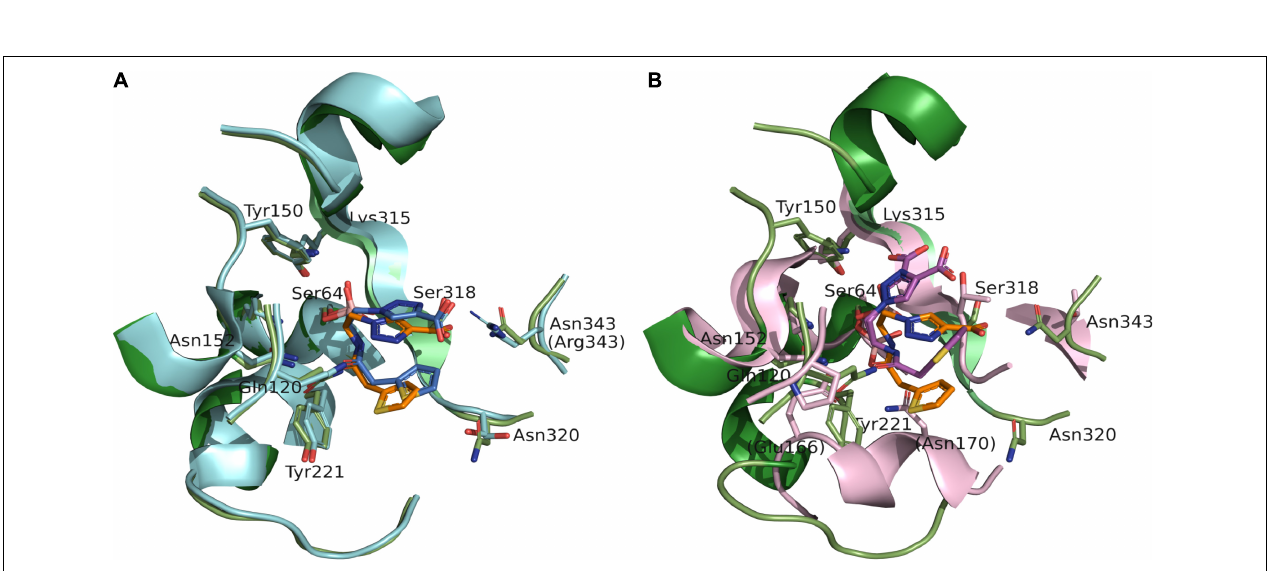
FIGURE 3 | Superposition of S02030: MOX-1 (orange: green) and previously analyzed crystal structures of S02030: ADC-7 (PDB: 4U0X) [ (A) blue: cyan] and S02030: KPC-2 (PDB: 5EEC) [ (B) violet: pink]. The labels in parentheses indicate the residues of ADC-7 (A) and KPC-2 (B) .